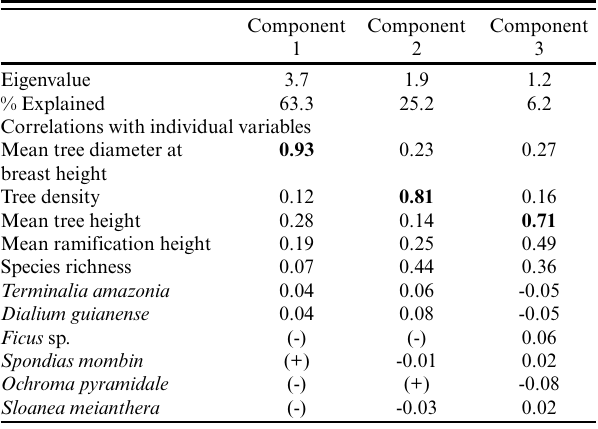
Table 2 . Principal components analysis of forest structure and floristic composition variables within a 25-m radius of point counts in tropical moist forest of Los Chimalapas, Mexico (r > 0.7 marked in bold